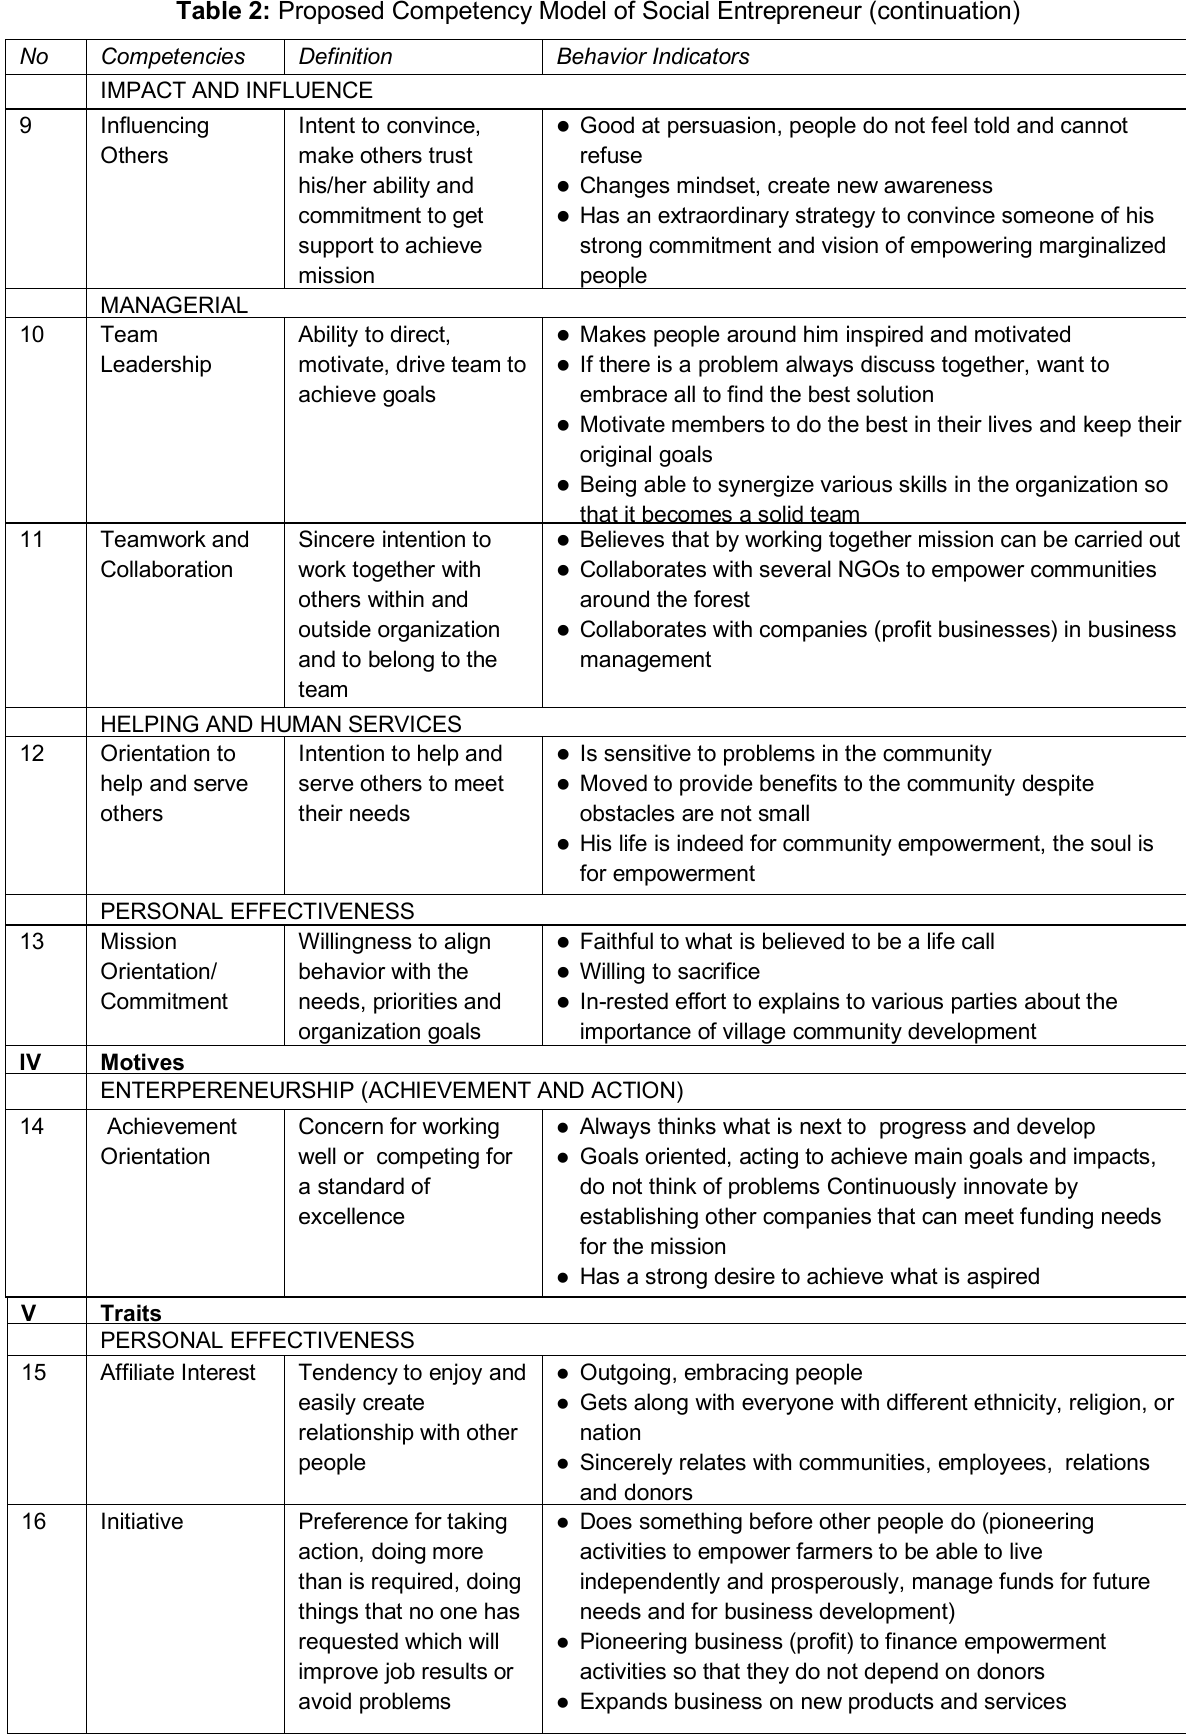
Table 2: Proposed Competency Model of Social Entrepreneur (continuation)